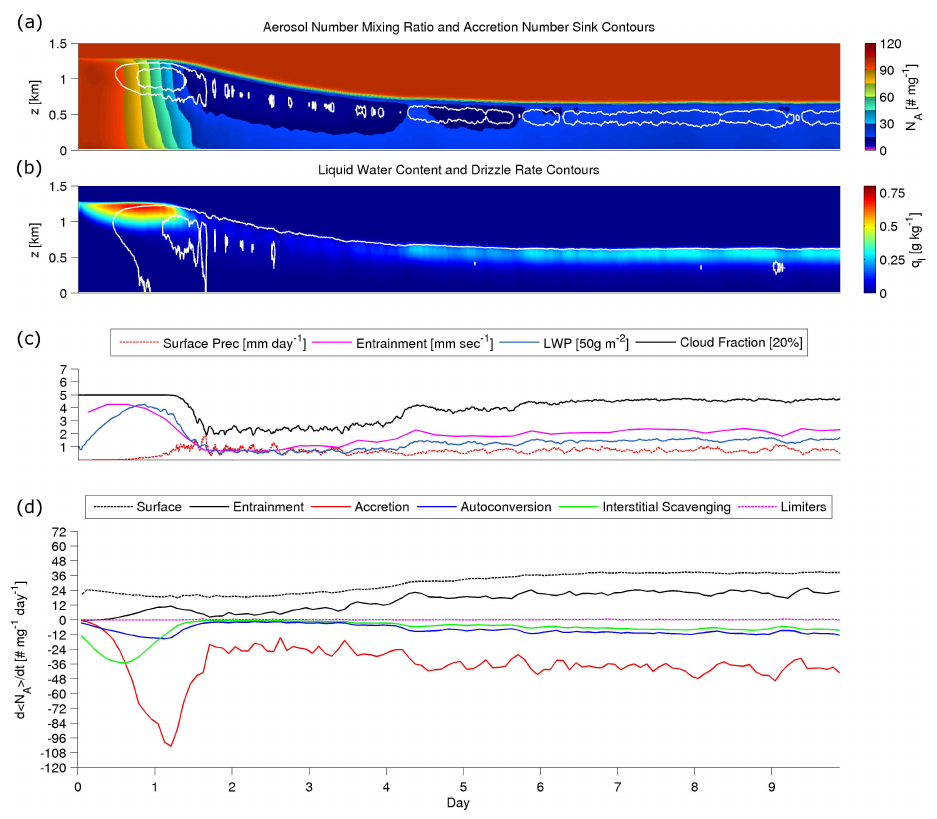
Fig. 6. Time-height plots and time series for run W5/NA100/3-D. Panels as in Fig. 4. Unlike the 2-D case, the time axis only goes to 10 days.